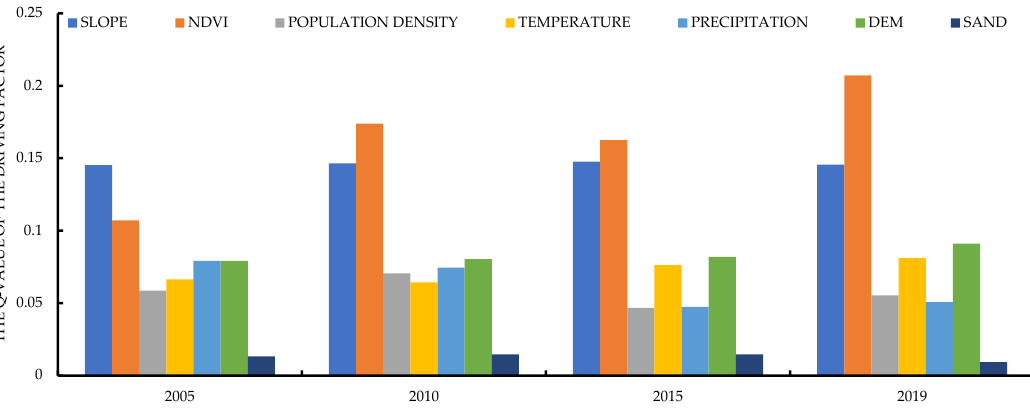
Figure 6. Detection results of factors affecting the spatial distribution of carbon storage.